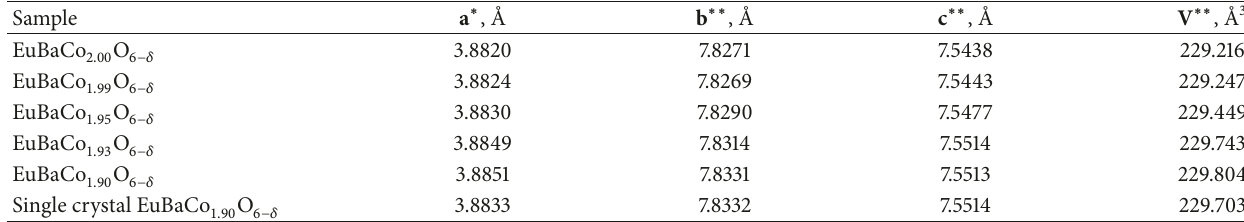
Figure 3: Photo of the [ 001 ] cleavage surface of the grown EuBaCo 1.90 O 6−𝛿 single crystal (on the left) and elements distribution (on the right): (a) across the sample, (b) along the sample. Table 2: Cell parameters of double perovskites EuBaCo 2−𝑥 O 6−𝛿 ( 𝑥 = 0–0.1).